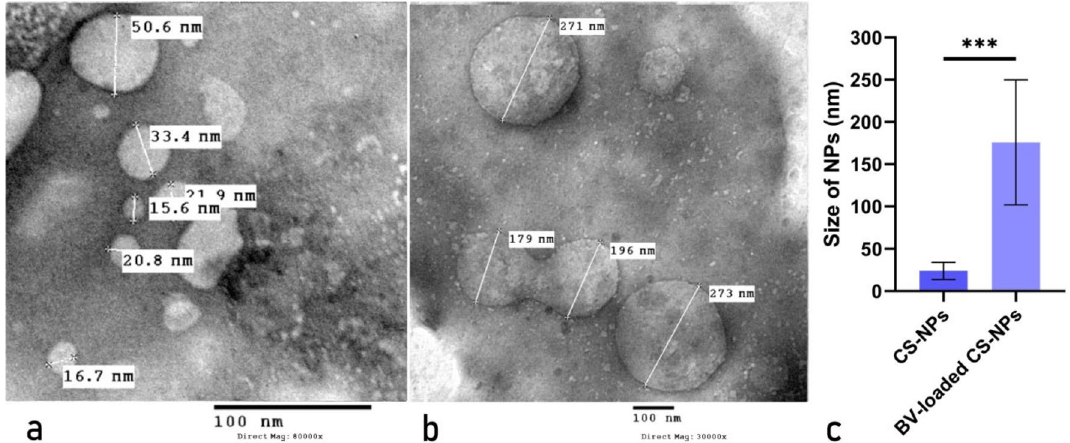
Figure 2. Particle size distribution of ( a ) CS-NPs and ( b ) BV-loaded CS-NPs obtained by (TEM). ( c ) The sizes of prepared NPs. Data were analyzed using a one-sample t-test and represented as Mean ± Standard Error of mean (SEM). (***) is considered highly significant P < 0 . 0001. -CS-NPs: Chitosan nanoparticles, BV-loaded CS-NPs: Bee venom-loaded Chitosan nanoparticles.